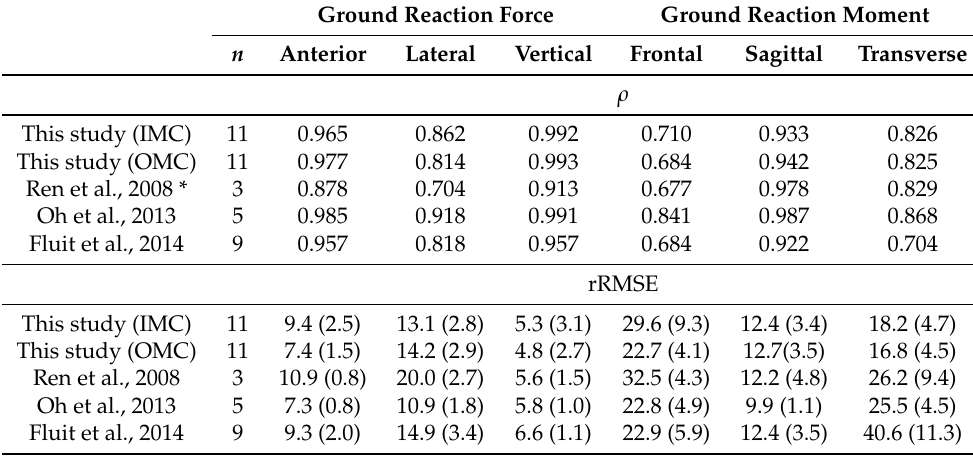
Table 11. Pearson’s correlation coefficients ( ρ ) and relative root mean square errors (rRMSE) found in our IMC-based and OMC-based results and reported by previous studies based on optical prediction for normal walking [14,16,19]. The values marked with (*) are sourced from the 10-fold cross-validation performed by Oh et al. [14]. The number of subjects used in each study is denoted by n